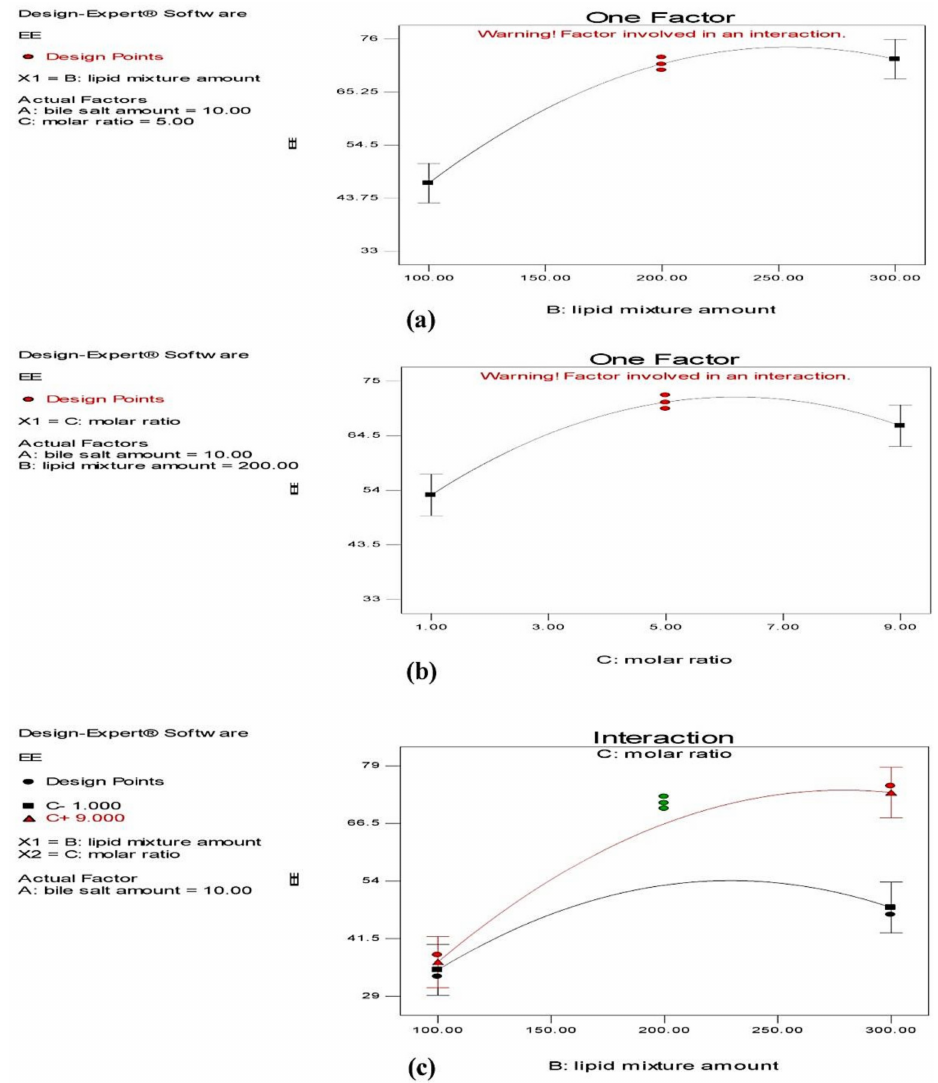
Figure 1. Line plots for the effects of cholesterol/Span ® 40 mixture amount ( a ) and cholesterol: Span ® 40 molar ratio ( b ), and the interactions between them ( c ) on entrapment efficiency of the prepared zolmitriptan-loaded